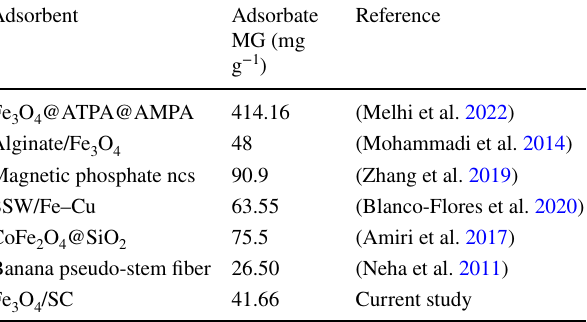
Table 7 Comparison of Langmuir adsorption capacities of MG with results from previous